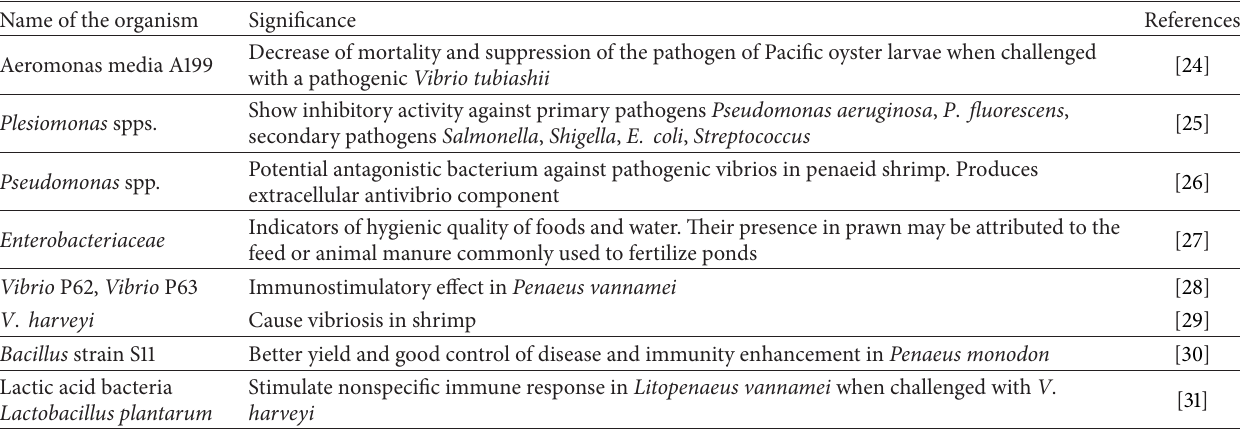
Table 2: Indigenous microbiota of shrimp and their